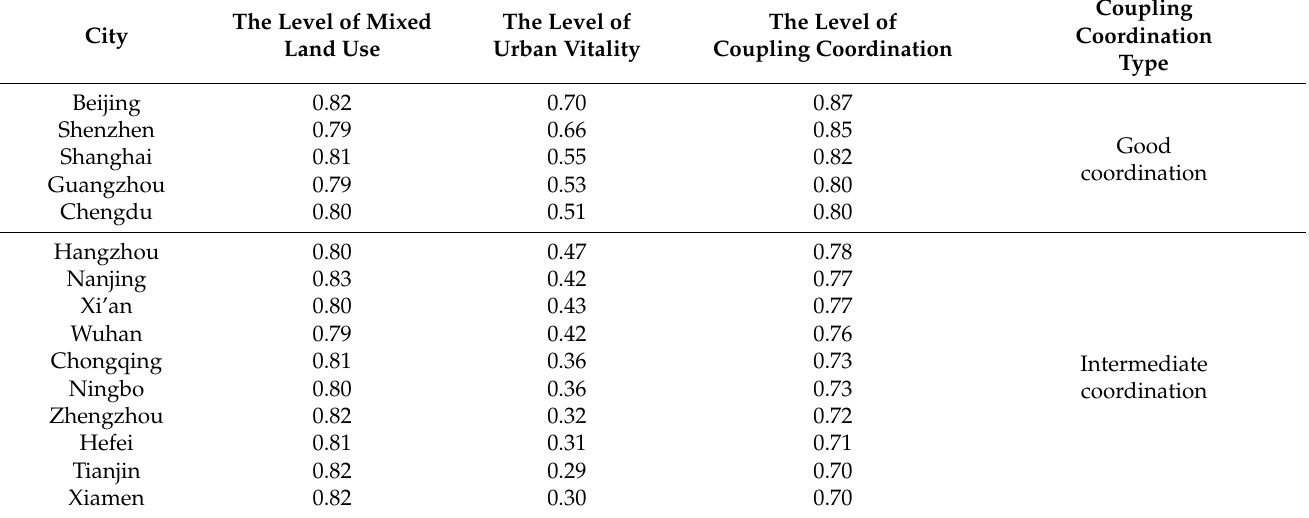
Table 4. Results of coupling coordination